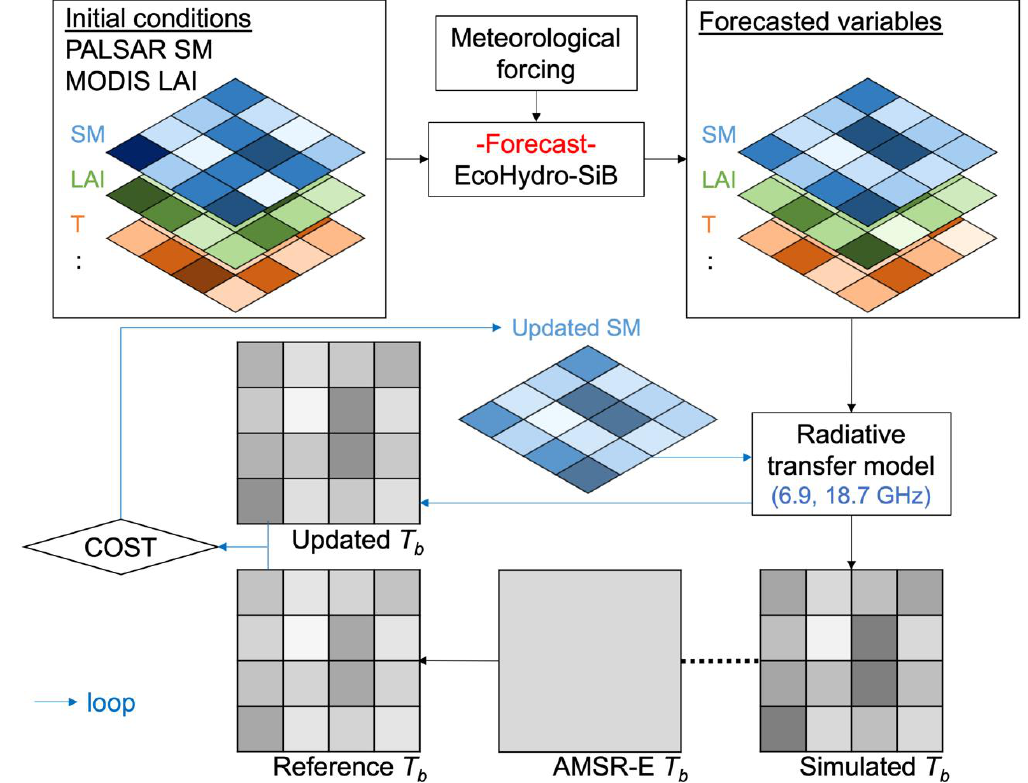
Figure 3. Schematic representation of the assimilation system. High-resolution initial conditions of soil moisture (SM) and leaf area index (LAI) are obtained from PALSAR and MODIS observations.